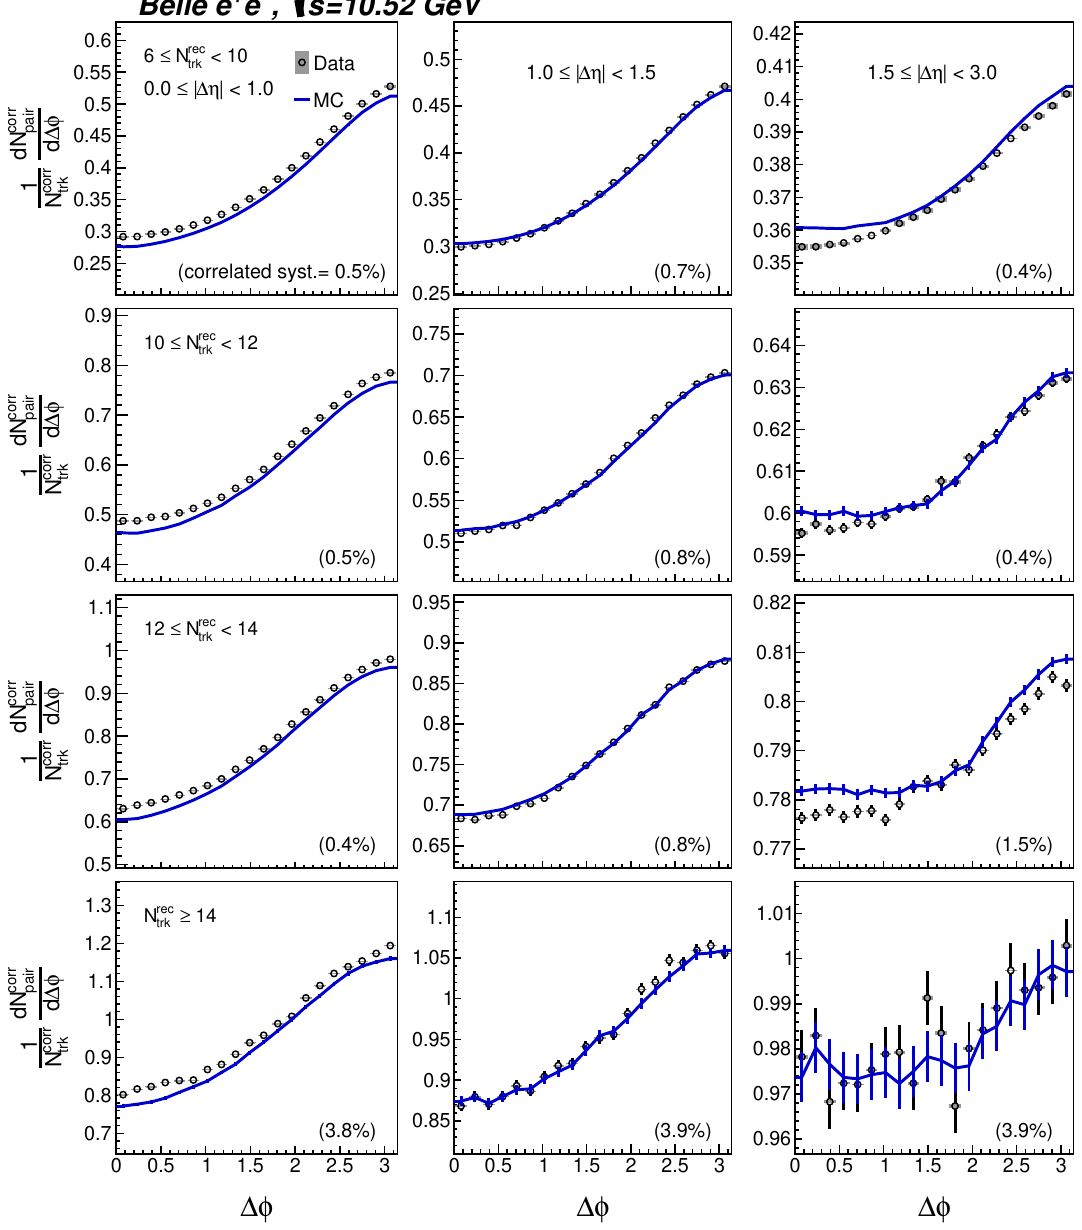
Figure 7. Thrust-axis azimuthal differential associated yields as a function of the reconstructed- track multiplicity N rec for the off-resonance sample in the short-range ( 0 ≤ | ∆ η | < 1 ), middle-range trk ( 1 ≤ | ∆ η | < 1 . 5 ) and long-range ( 1 . 5 ≤ | ∆ η | < 3 . 0 ) regions in columns from left to right,